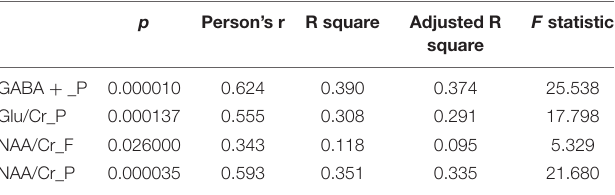
p Person’s r R square Adjusted R